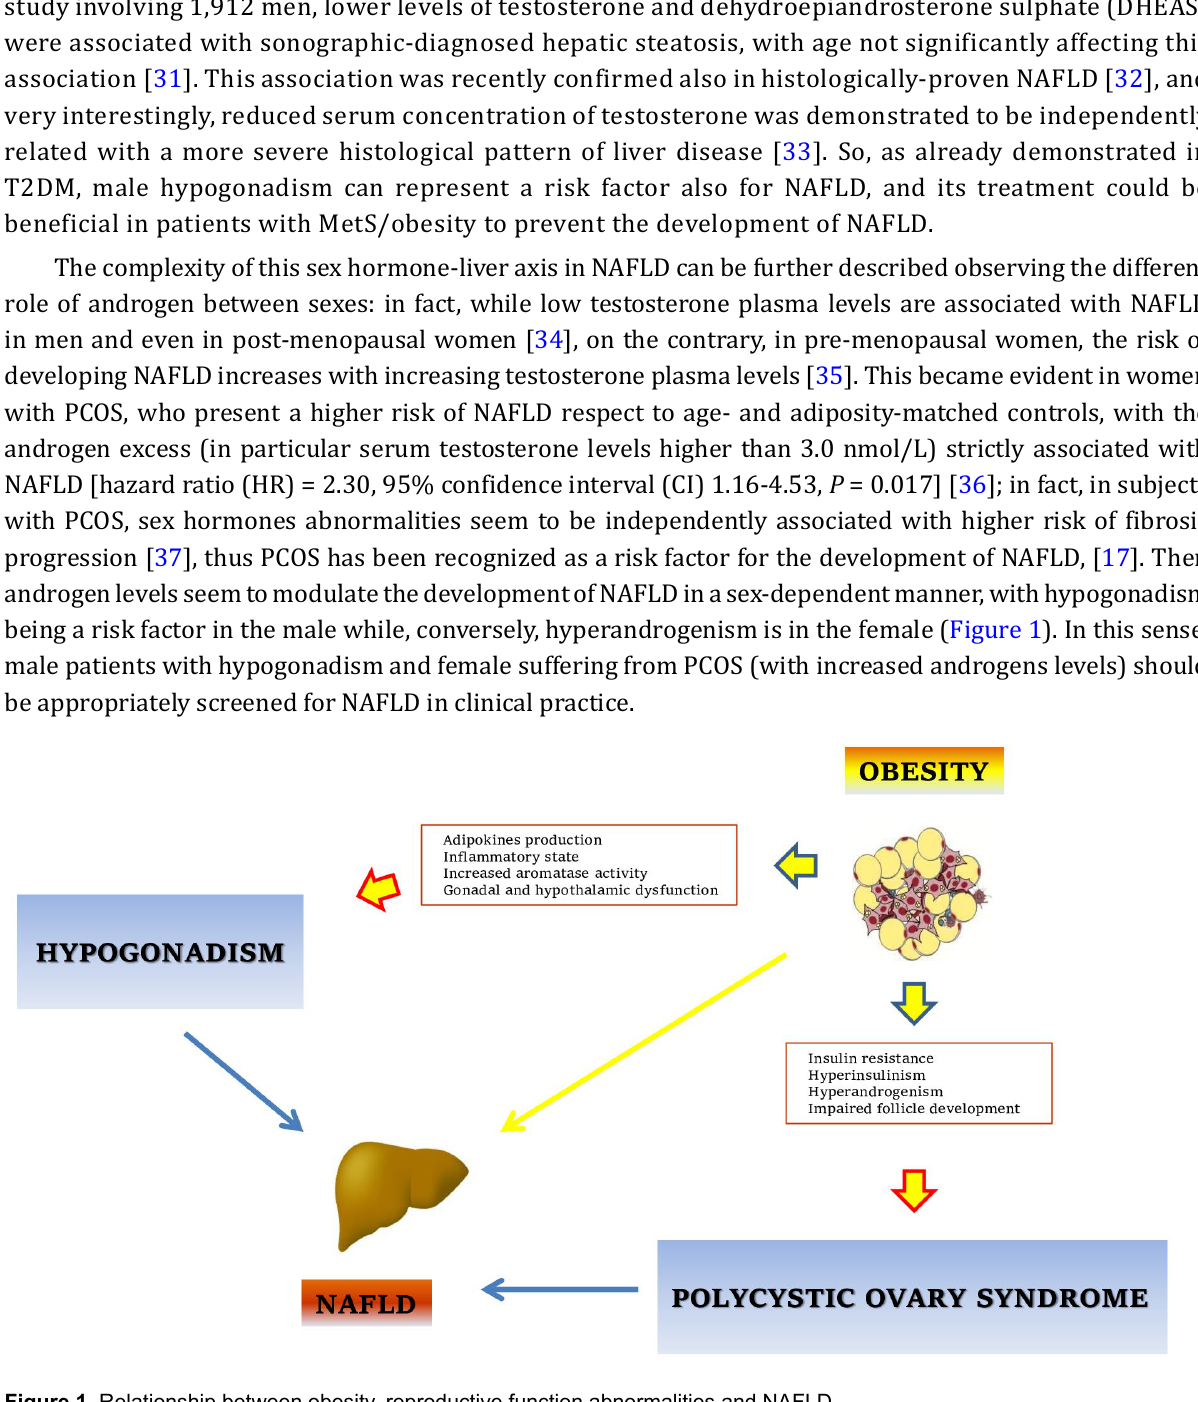
Figure 1. Relationship between obesity, reproductive function abnormalities and